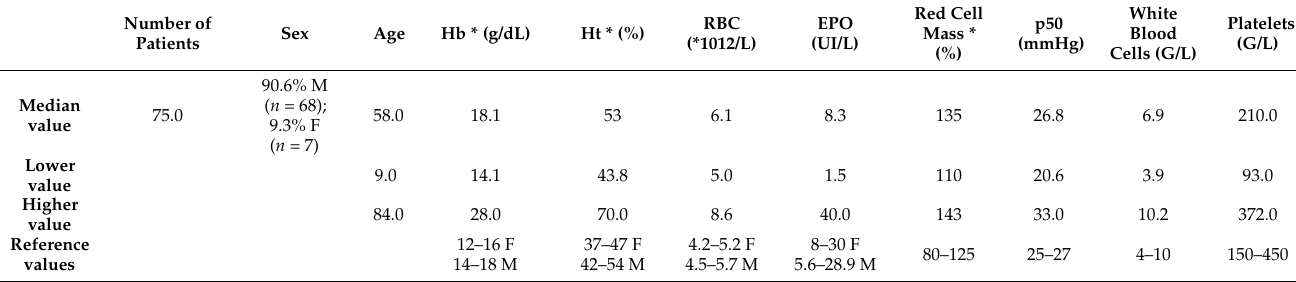
Table 1. Clinical and biological data of the